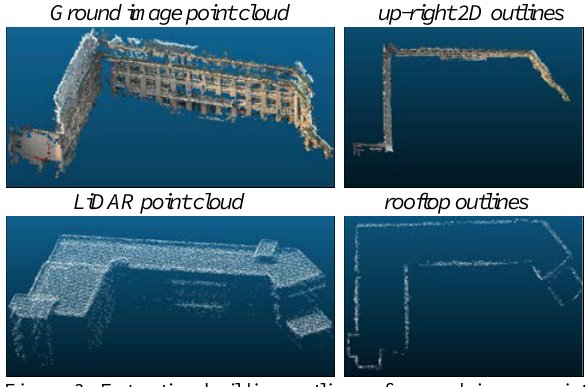
Figure 3. Extracting building outlines of ground image point cloud (top) and LiDAR point cloud